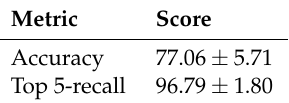
Table 2. Results from the plant species classification baseline. The reported values are the mean and standard deviation over all ten splits in the 10-fold cross-validation